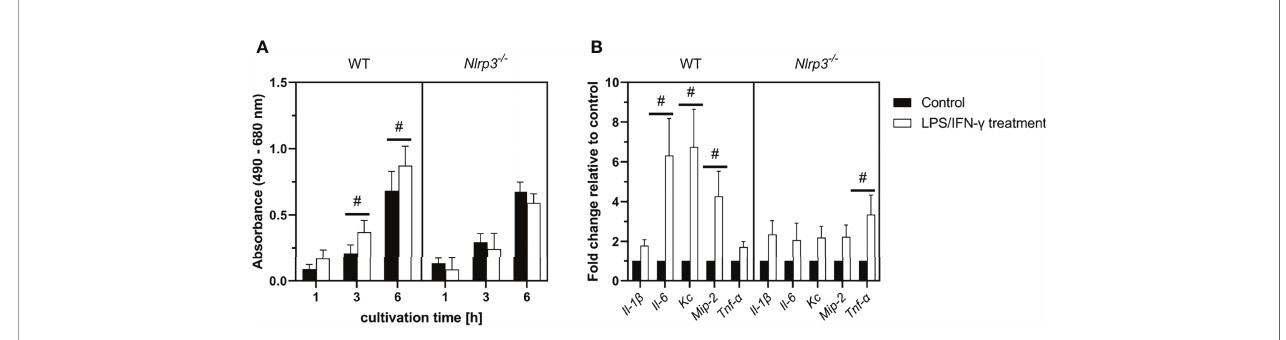
FIGURE 8 | (A) LDH activity in the supernatants of LPS/IFN- g -treated ileal tissue explants from WT or Nlrp3 -/- mice after 1, 3, or 6 (h) (B) Gene expression in ileal tissue explants after 6 h of treatment. Mean ± SEM of N = 4, # p < 0.05 compared to the untreated control of the corresponding